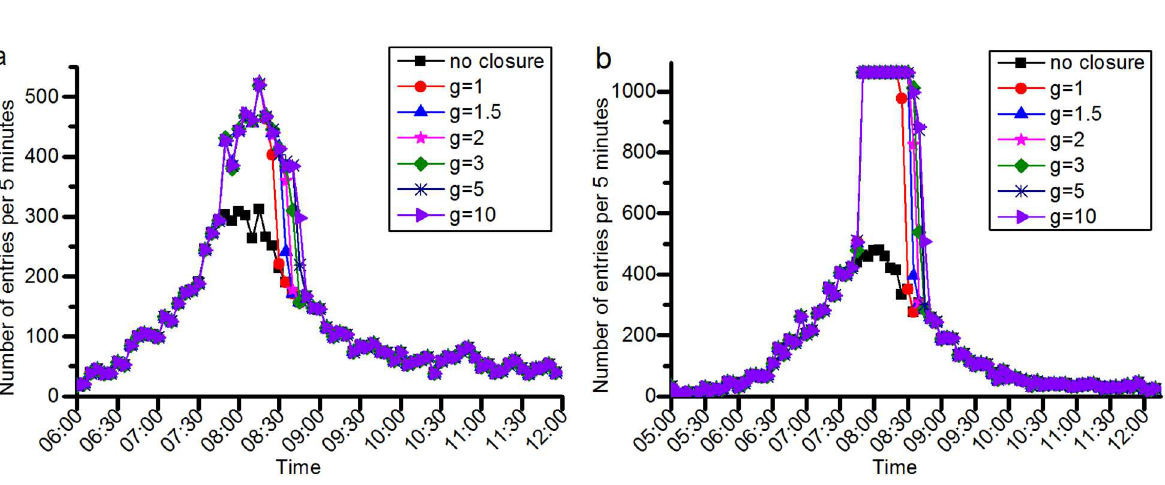
Fig 23. The number of entries at the affected stations for varying values of g . (a) shows the numberof entries at GULOUDAJIE station in the JISHUITAN case. (b) shows the number of entries at TIANTONGYUAN South station in the TIANTONGYUAN case. The inboundcapacityof the GULOUDAJIE is 1000 personsper 5 minutes, and the TIANTONGYUAN South station is 1062 personsper 5 minutes. As shown in the first closurecase in Fig 23(a), when g equals1, the GULOUDAJIE station experiences1,284 more entries than in the no closure case. However, in the case of g equal to 10, this difference is 2,064, which is 60.9% more than that in the case of g equal to 1. The durationin the case of g equal to 10 is 60 minutes, which is 33.3% more than in the case of g equal to 1. As shown in the second closurecase in Fig 23(b), when g equals1, the TIANTONGYUAN South station experiences 4,979 entries more than in the no closure case. However, in the case of g equal to 10, this difference is 7294, which is 46.5% more than that in the case of g equal to 1. The duration in the case of g equal to 10 is 65 minutes, which is 44.4% more than in the case of g equalto